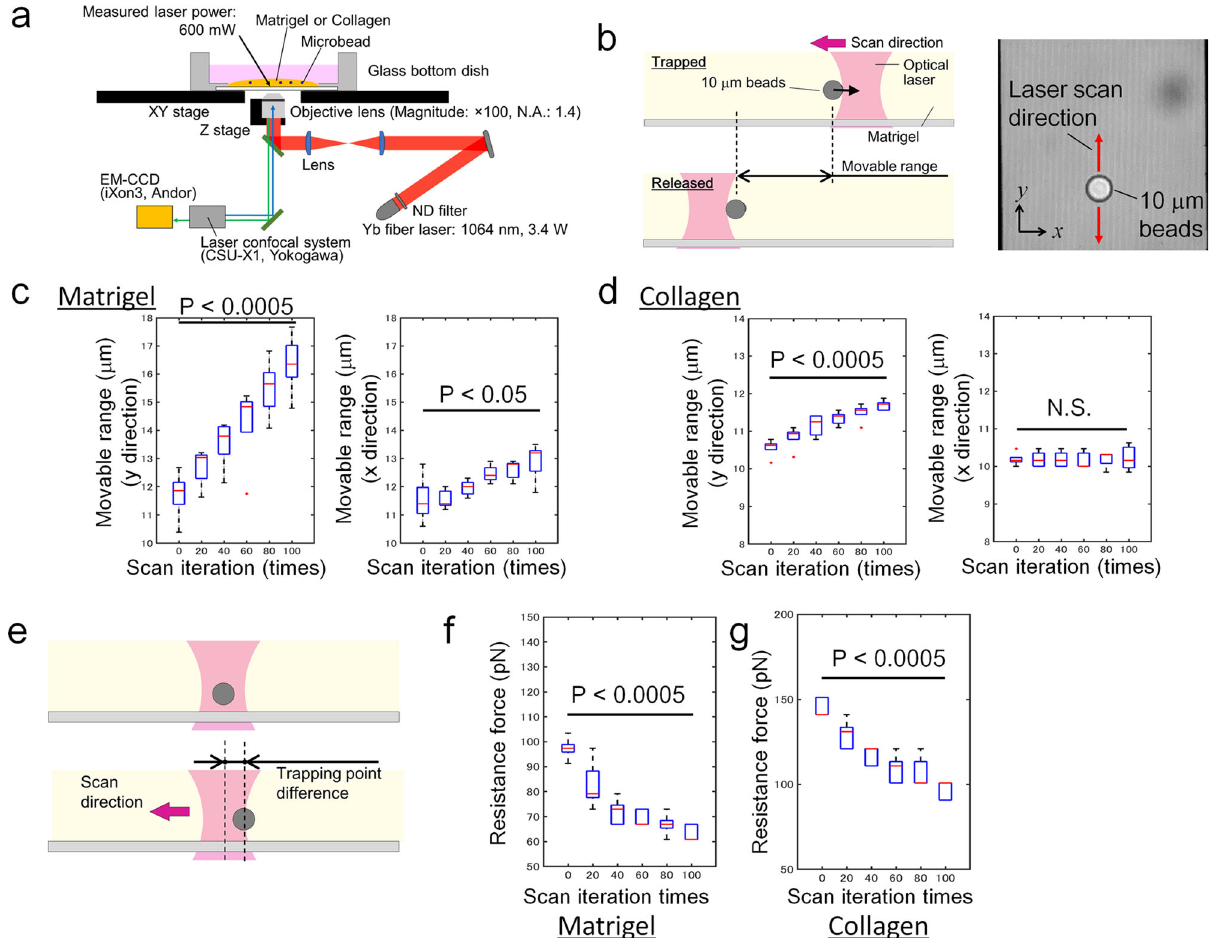
Fig. 4 Effects of physical movements in the ECM on resistance force. a Experimental setup for optical tweezers system. b Schematic diagram for the measurement of the movable range of microbeads under constant manipulation to examine the modulation of ECM by the repetitive movement of micro- objects. The 10 µ m beads were repetitively manipulated along the y axis by optical tweezers with 600 mW of output laser power. c Experimental results for the measurement of the movable range of the microbeads in matrigel. Five microbeads in matrigel were selected to conduct the experiments, and the data show the means ± SDs ( n = 5). d Experimental results for the measurement of the movable range of the microbeads in collagen I. Five microbeads in collagen were selected to conduct the experiments, and the data show the means ± SDs ( n = 5). e Schematic diagram of the measurement of resistance force from the ECM using optical tweezers. In all, 10 µ m beads were repetitively moved, and the dynamic change in resistance force was calculated by measuring the distance between the centre of the laser and that of the trapped beads. f Experimental results of the resistance force in matrigel. Five microbeads in matrigel were selected to conduct the experiments, and the data show the means ± SDs ( n = 5). g Experimental results of the resistance force in collagen I. Five microbeads in collagen were selected to conduct the experiments, and the data show the means ± SDs ( n = 5). Student ’ s t test was employed for the statistics ( c , d , f , g ). The elements in boxplots are de fi ned as follows; centre line, median; box limits, upper and lower quartiles;